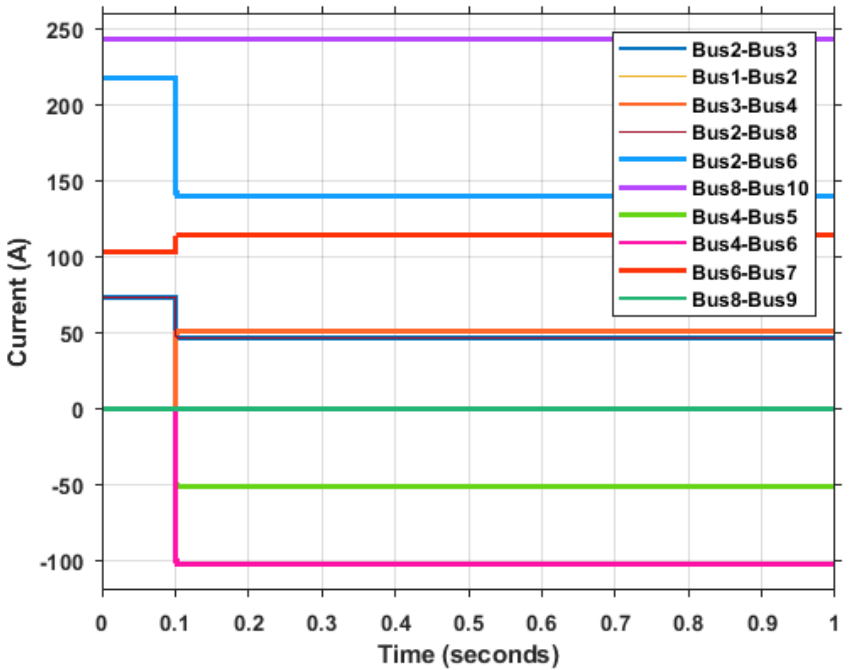
Figure 18. Currents through the DC microgrid feeders before/after connecting a normal conductor.